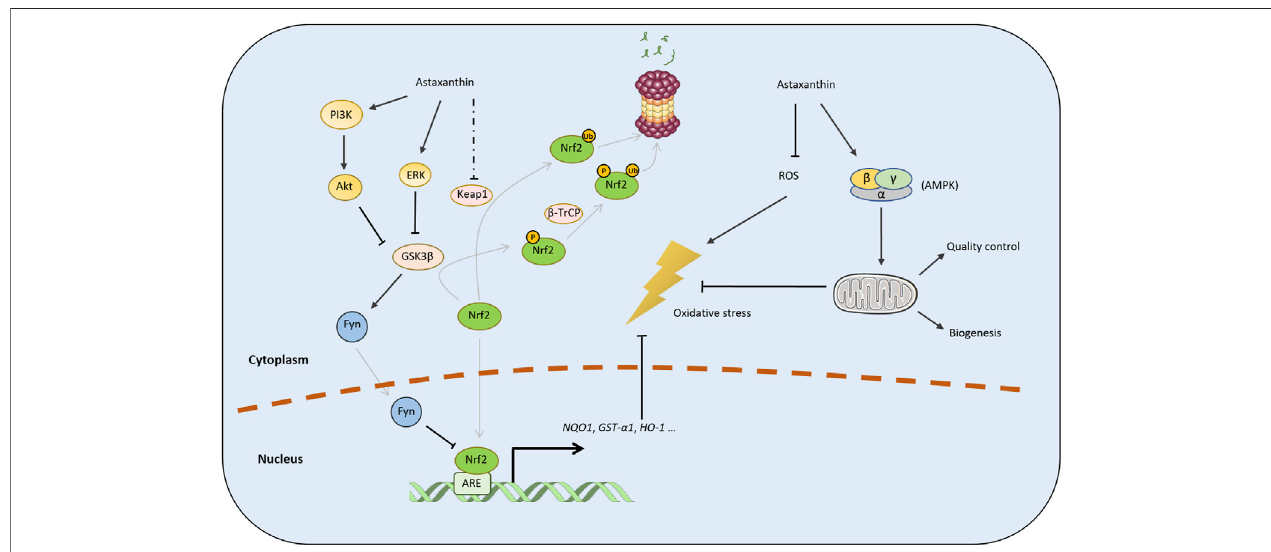
FIGURE 2 | Mechanisms by which astaxanthin defends against oxidative stress. Astaxanthin mitigates oxidative stress by directly scavenging radicals and regulating the cellular antioxidative enzymatic system via the Nrf2 pathway. The black arrows represent positive regulation, while the lines with T-shaped ends represent inhibition. A dotted line indicates an inconclusive pathway. The gray lines indicate phosphorylation, ubiquitination, or nuclear translocation. P and Ub represent the phosphorylation and ubiquitination of target proteins,